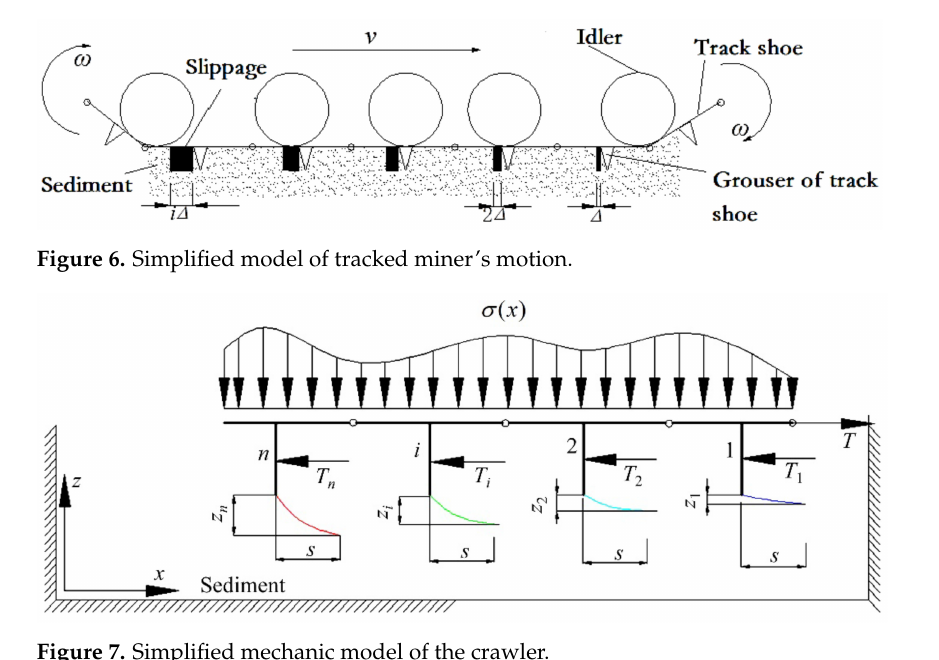
Figure 7. Simplified mechanic model of the